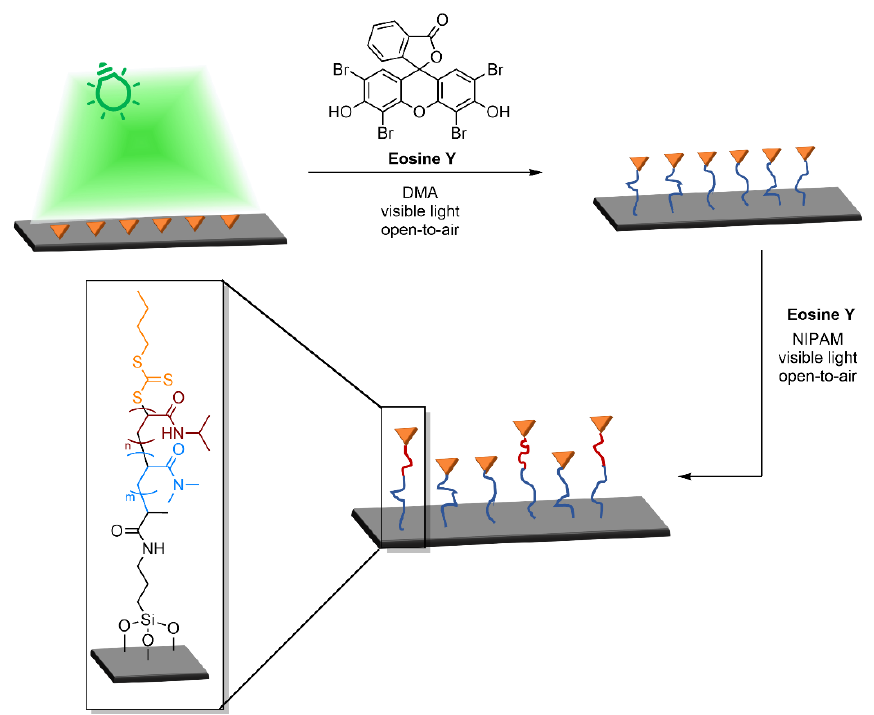
Figure 13. Schematic representation SI-PET-RAFT polymerization exploiting BTPA chain transfer agent anchored to a substrate. P(DMA-block-NIPAM) block copolymer synthesis exploiting photomask to obtain specific surface pattern.